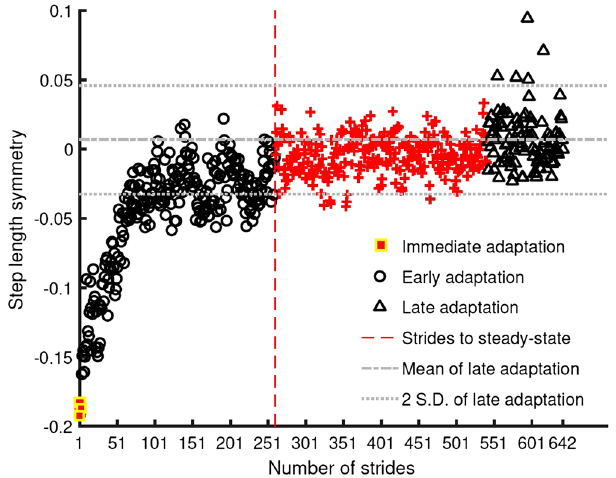
Figure 3. Symmetry series from a single participant during the adaptation phase illustrating how motor performance (immediate, early and late) and strides to steady-state were calculated for each